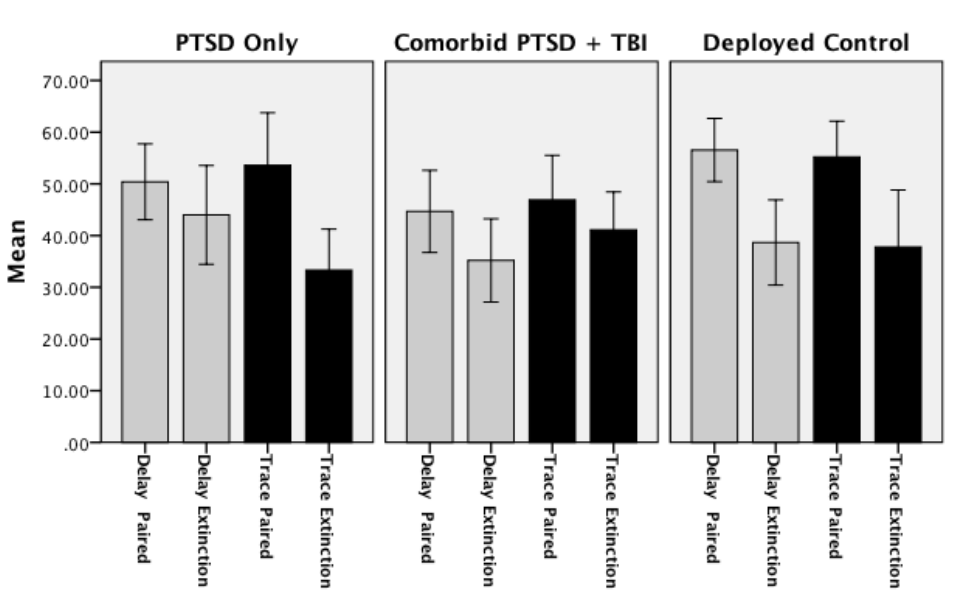
Figure 4. Delay and trace extinction: mean percent conditioned responses for final 3 blocks of paired trials and 3 block of extinction trials (error bars: +/ − 2